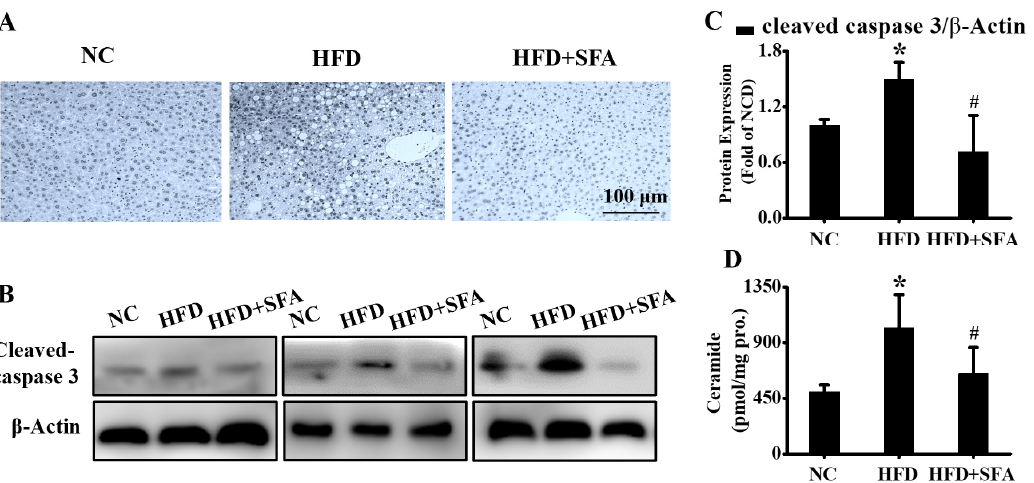
Figure 6. Evaluation of hepatic apoptosis and ceramide contents after SFA treatment to HFD-fed C57BL/6J mice: ( A ) the hepatic apoptosis in different groups examined by TUNEL assay. ( n = 5/group); ( B ) Western blot analysis showed the levels of cleaved caspase 3 and ( C ) gray analysis of each band in liver ( n = 3/group); ( D ) total ceramide contents in liver detected by LC/MS/MS ( n = 4–5/group). All values are expressed as means ± SD, * p < 0.05 vs. NC group; # p < 0.05 vs. HFD group.